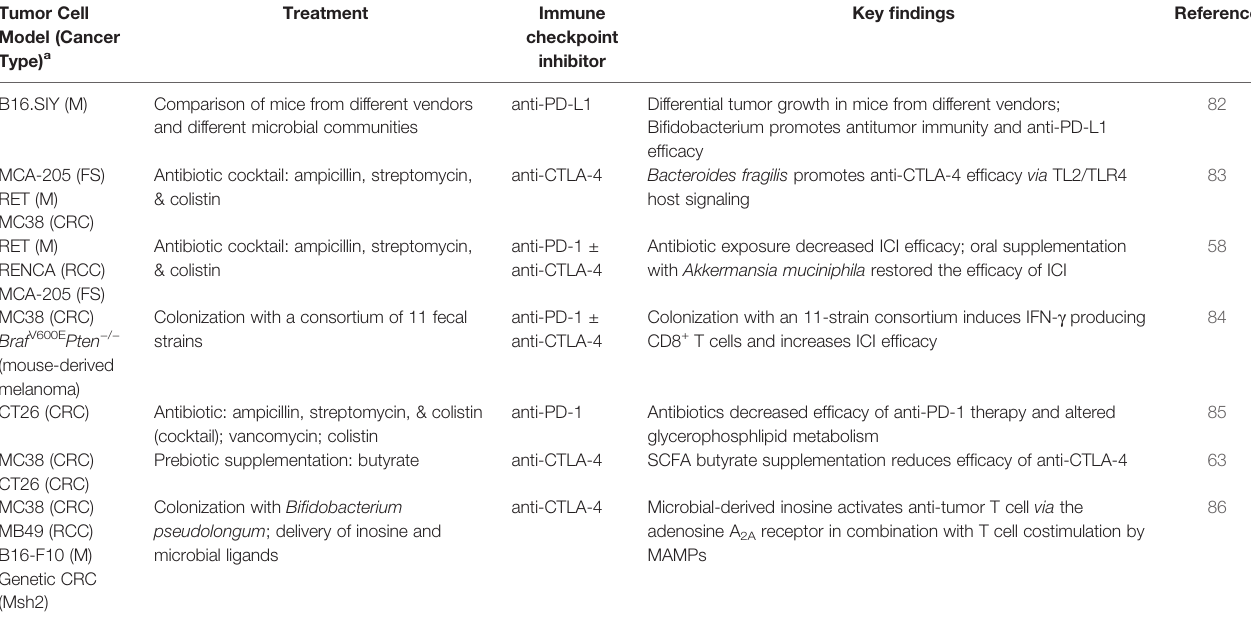
TABLE 2 | Impact of gut microbiome on immune checkpoint inhibitor therapy: selected preclinical studies. Tumor Cell Model (Cancer Type)